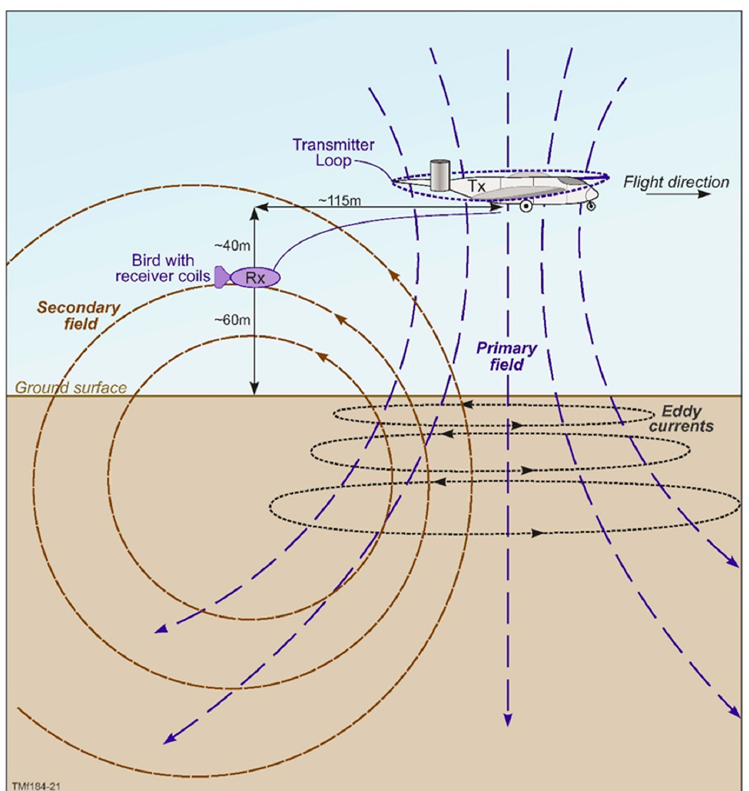
Figure A1. Principles of time domain EM data acquisition for a fixed-wing time domain EM system, such as the TEMPEST AEM system.